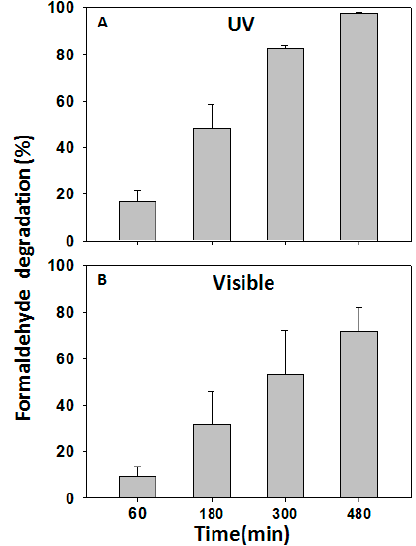
Figure 3. Degradation of formaldehyde by the 65/35 polyester/cotton TNP nanofabrics under UV radiation ( A ) and visible light ( B ). The error bars indicate the standard deviation value (SD) from average values of three independent measurements.